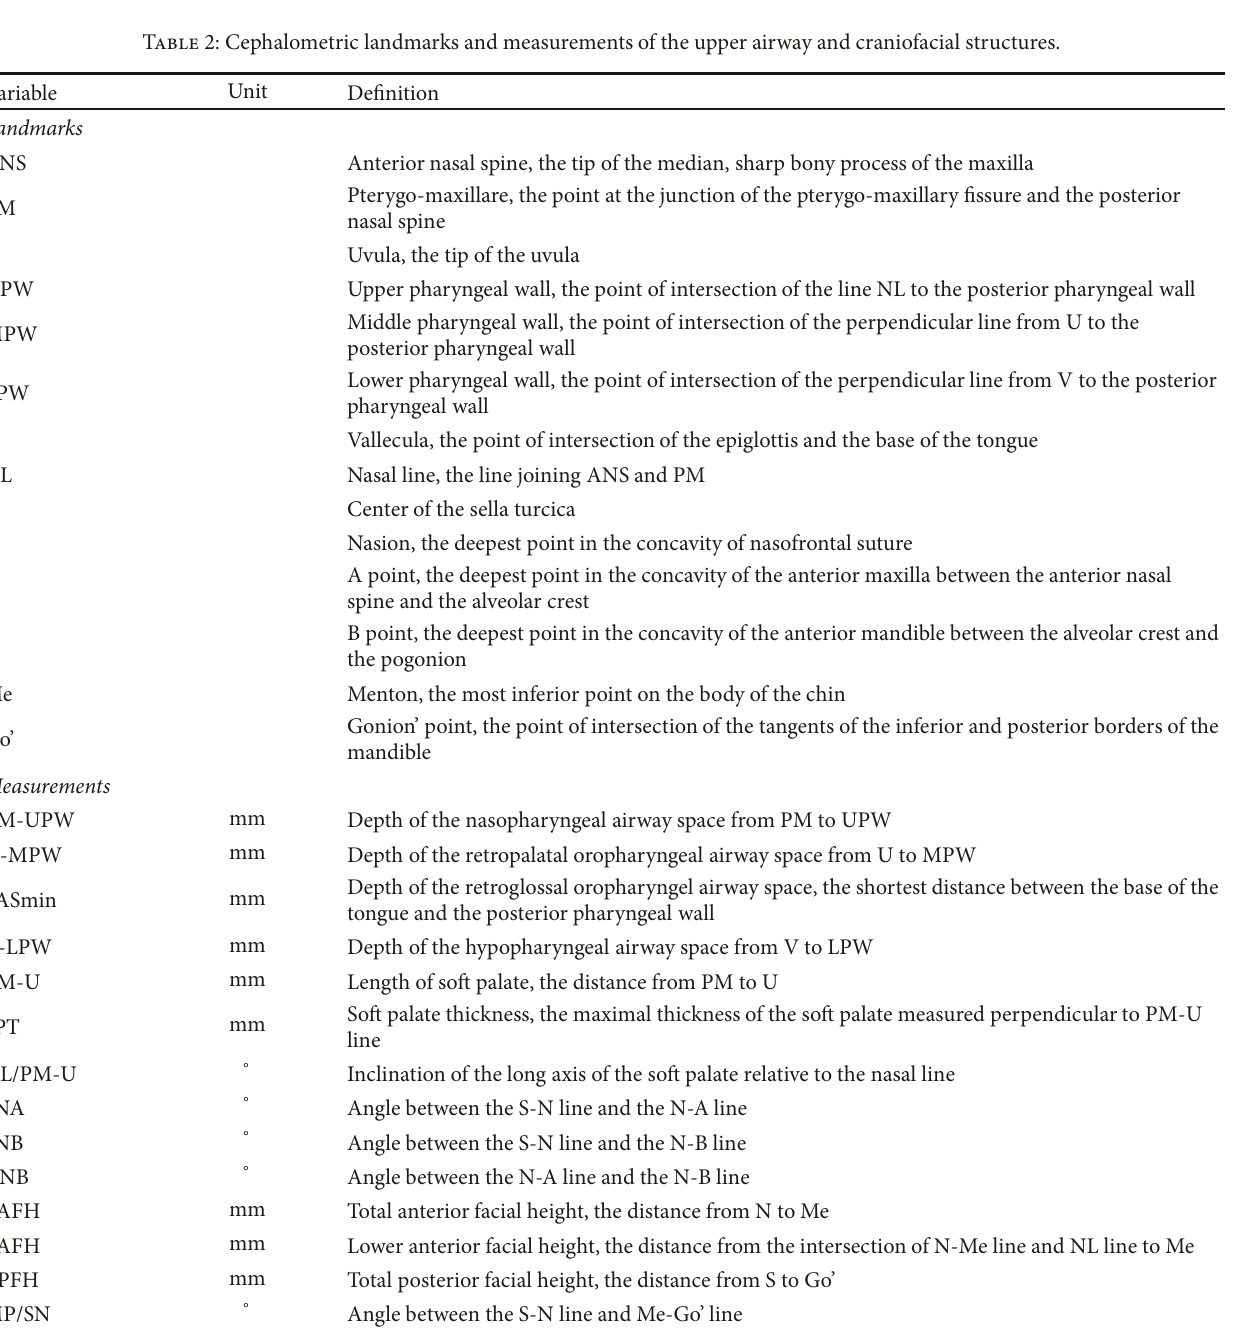
Table 2: Cephalometric landmarks and measurements of the upper airway and craniofacial structures. Variable Unit